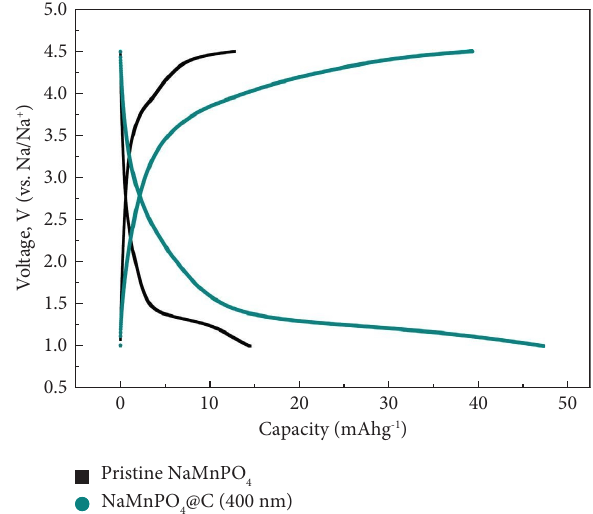
4 . Figure 5: Electrochemical performance of pristine and milled- coated NaMnPO 4 (cycle number